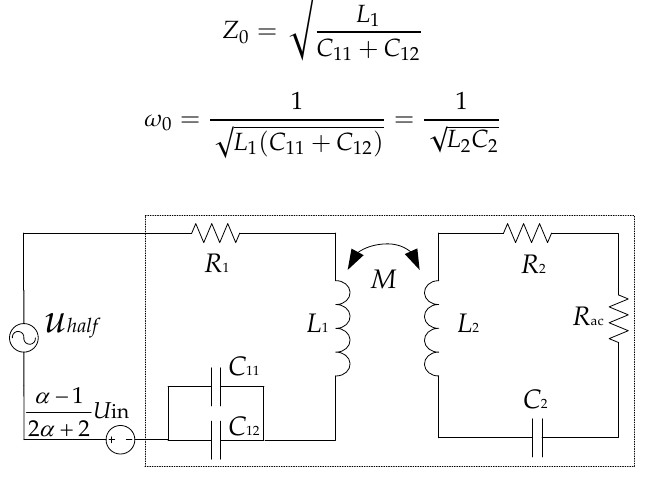
Figure 4. Equivalent circuit of SHRC IPT system.